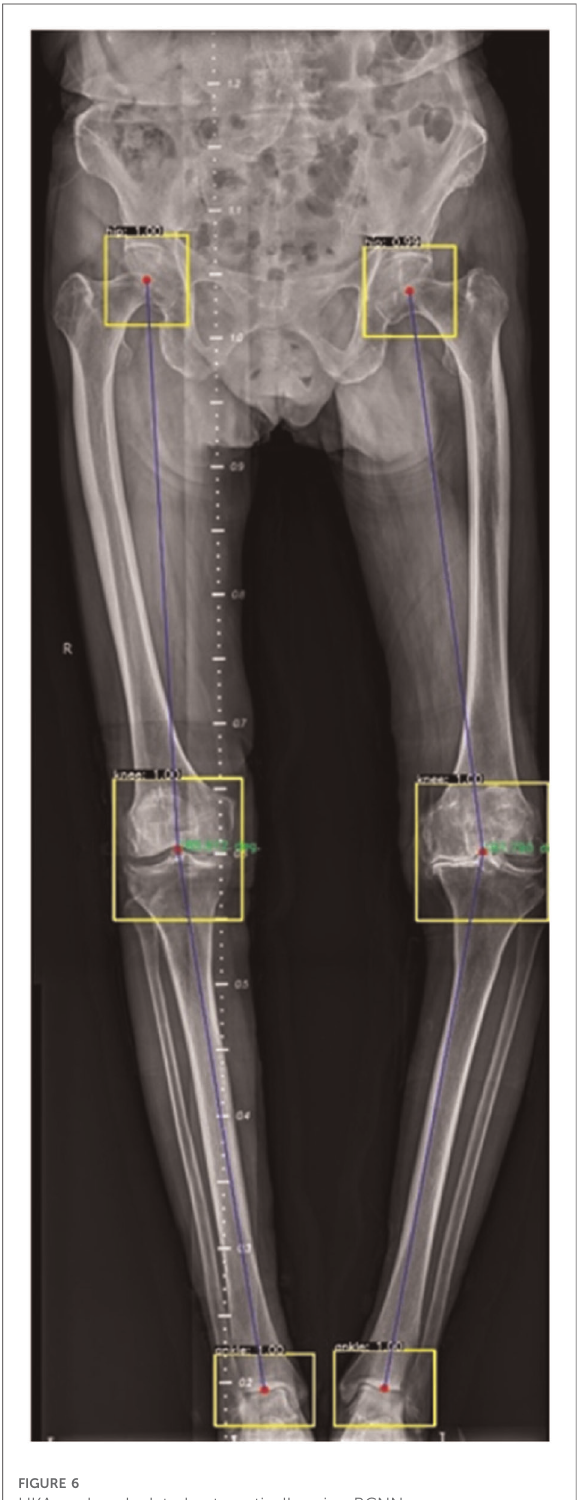
FIGURE 6 HKA angle calculated automatically using